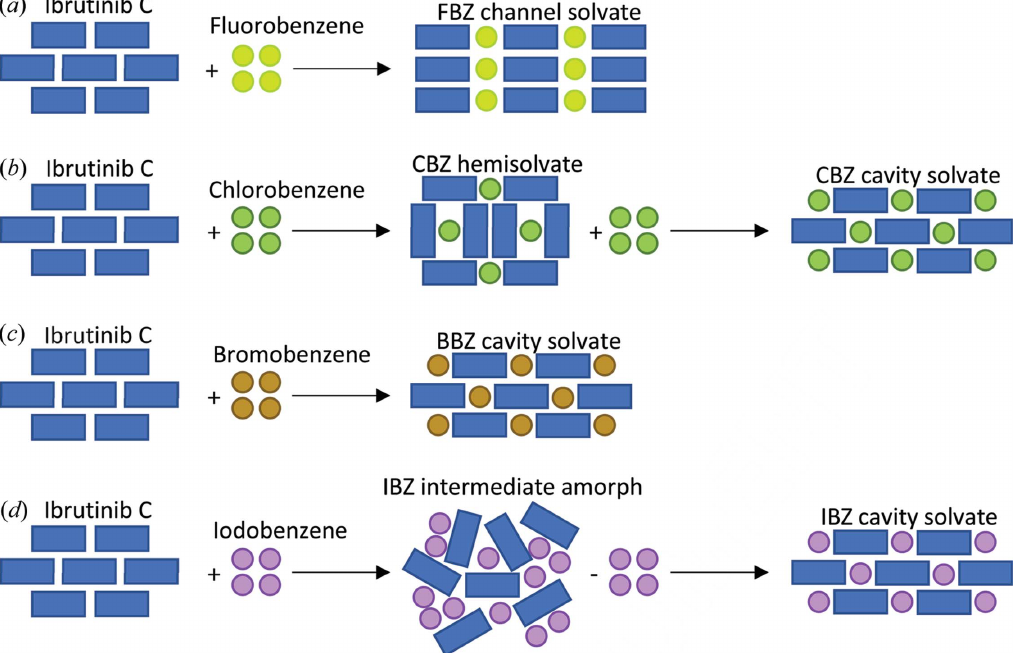
Figure 6 Different mechanisms of the transformation for FBZ, CBZ, BBZ and